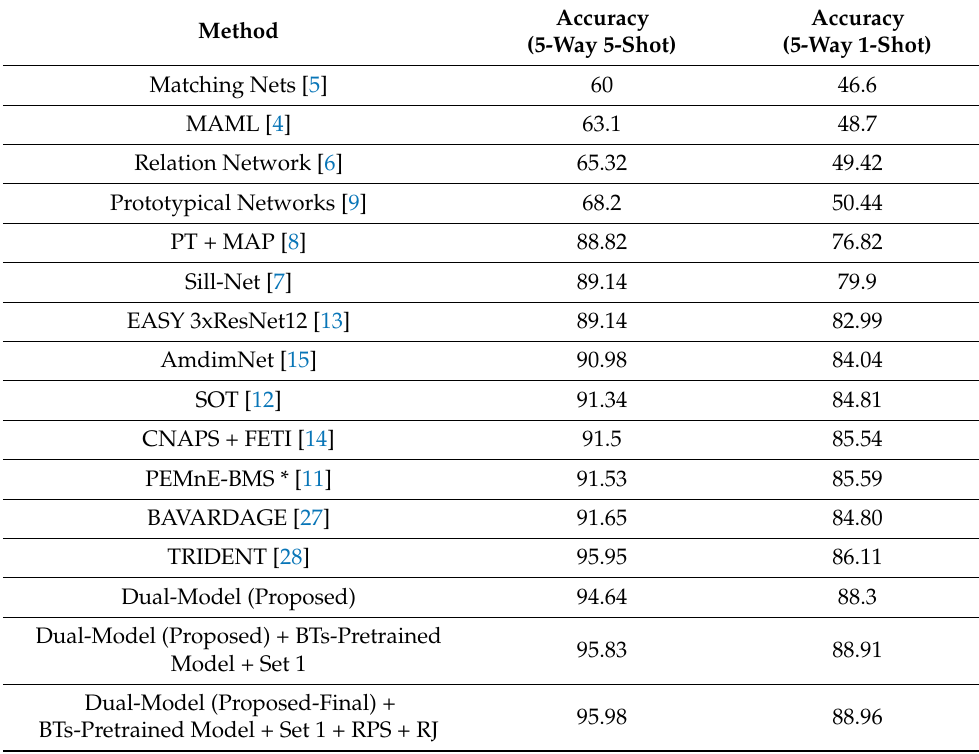
Table 3. Classification accuracy on Mini-ImageNet.